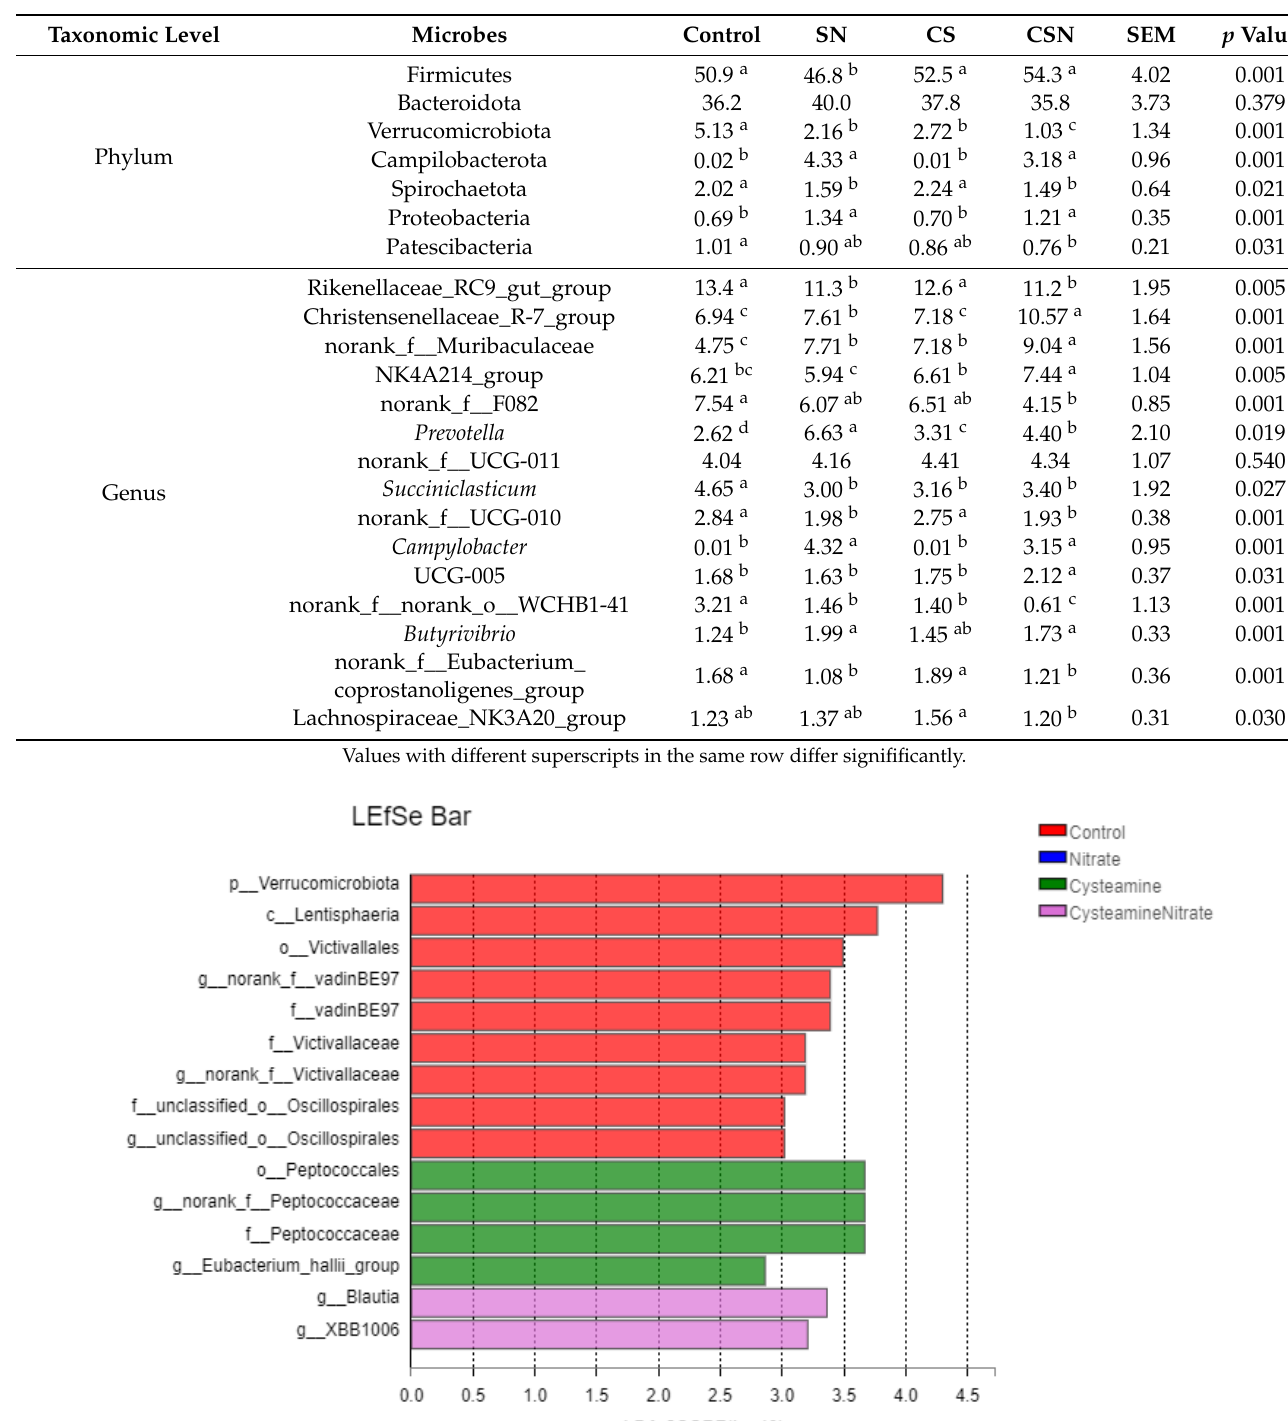
Table 7. Effects of sodium nitrate (SN), cysteamine hydrochloride(CS), and combination of CS and SN (CSN) supplementation on relative abundance of different bacteria phyla and genera (%).